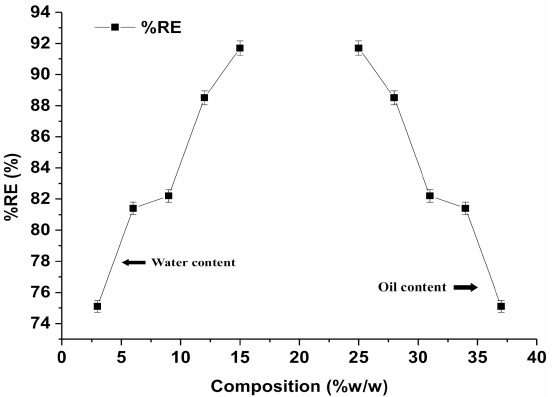
Figure 5. Effect of aqueous and oil phase concentration on %RE of RIF from the aqueous bulk solution through water/DMSOT/IPA/CMC8 nanoemulsions. Table 4. Results of %RE on to the surface of nanoemulsions (water/DMSOT/IPA/CMC8).